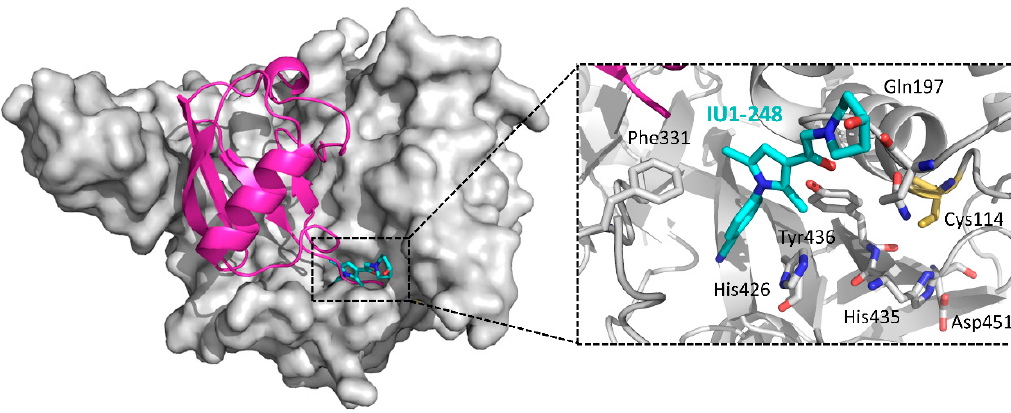
Figure 23. Cocrystal structure of USP14-IU1-248 and a close-up of the binding site (PDB ID: 6IIN). A ubiquitin molecule is modeled into the complex based on the superposition with a USP14CD-ubiquitin complex (PDB ID: 2AYO). Ubiquitin: magenta; USP14 catalytic domain: gray; IU1-248: cyan sticks. Hydrogen bonds: yellow dotted lines. Key residues involved in binding and the catalytic triad (Cys114-His435-Asp451) are shown as sticks, with Cys114 in orange. The ubiquitin C-terminal peptide RLRGG is omitted for clarity.